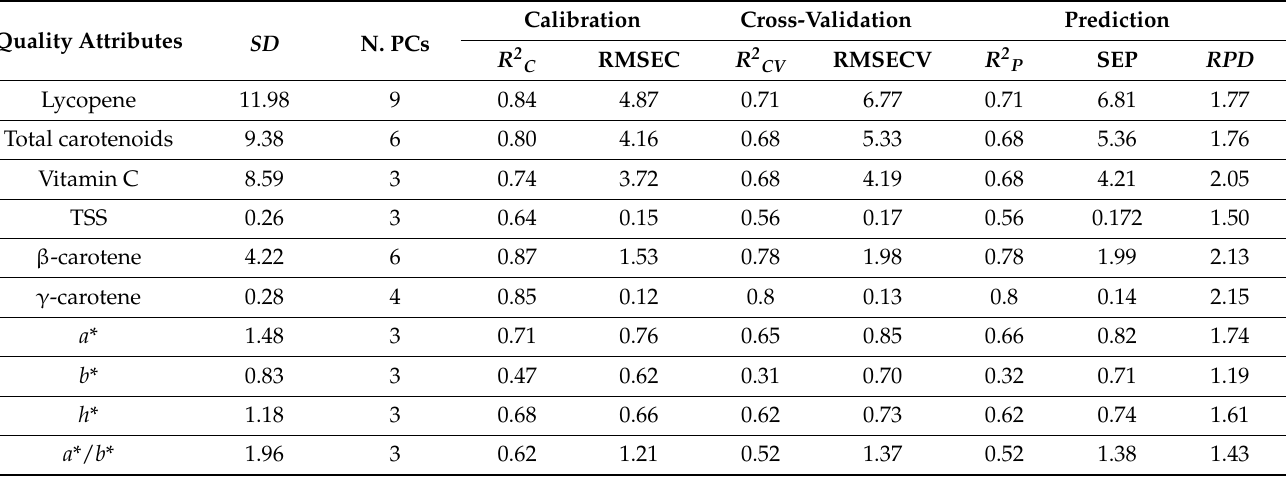
Table 2. Illustrates the predictive efficiency within the range 475–1075 nm of calibration models for watermelon chemical and color quality attributes.